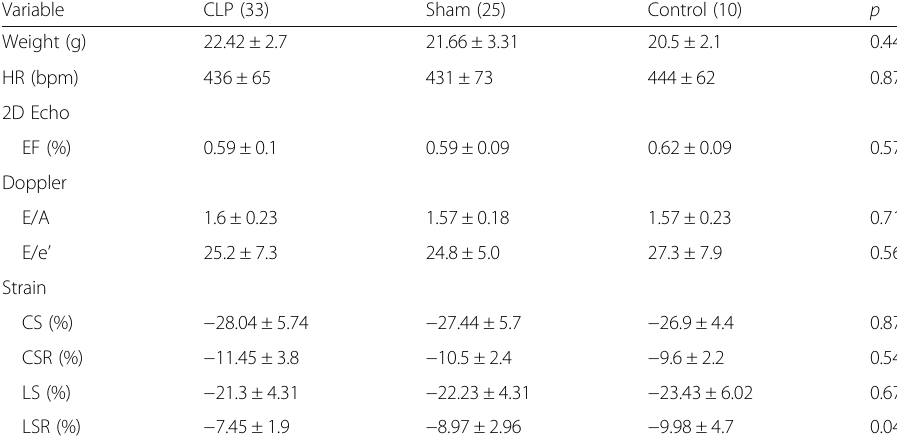
Table 1 Baseline characteristics and echocardiographic metrics for C57BL/6J mice Variable